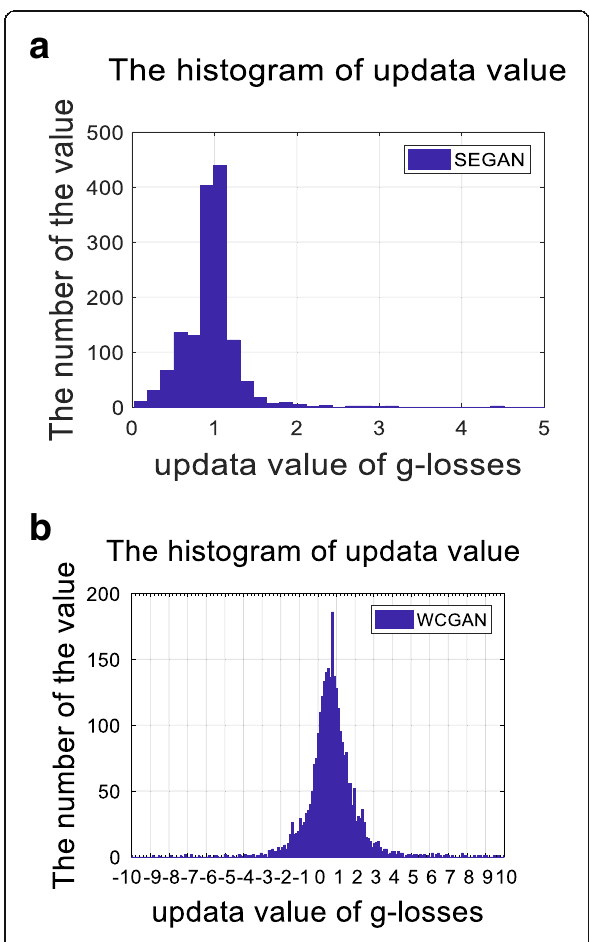
Fig. 5 The histogram of update value of the loss function for two models. a The histogram of the update value of the SEGAN generator. b The histogram of the update value of the improved WCGAN generator. The values in b mainly range from 0 to 2, and the uneven distribution is easy to cause insufficient learning in network. Relatively, the distribution of the value in a is uniform which ranges from − 4 to 4, which indicates that the network learning is full and the system performance is